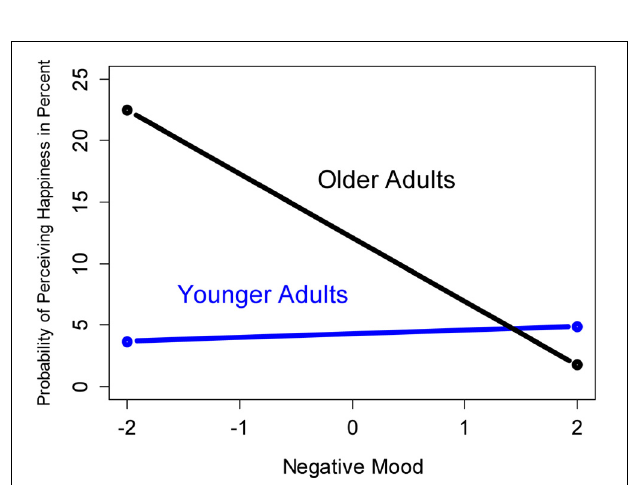
FIGURE 3 | Predicted probability of perceiving an additional happy emotional expression in faces for younger and older adults with maximally high (right) vs. maximally low (left) levels of negative